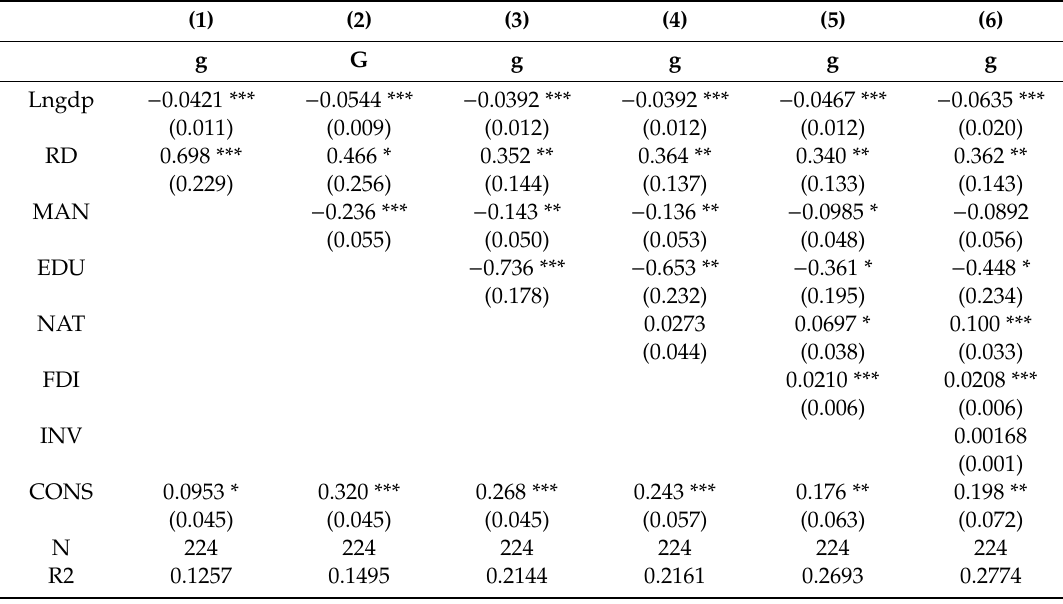
Table 3. Regressions for Equation